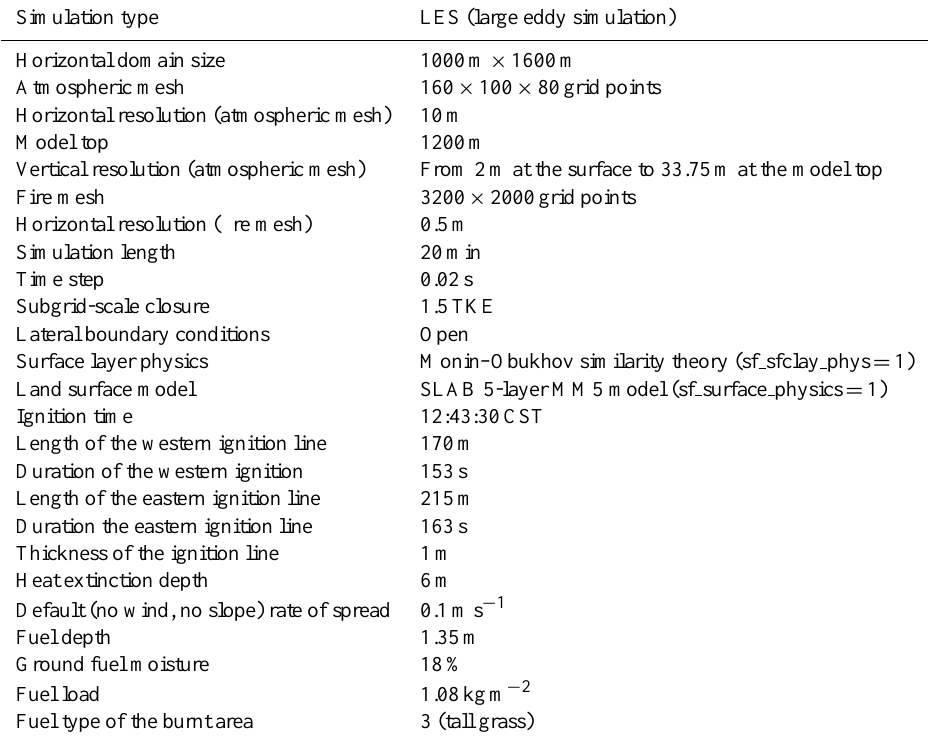
Table 2. Details of the numerical setup used for the FireFlux